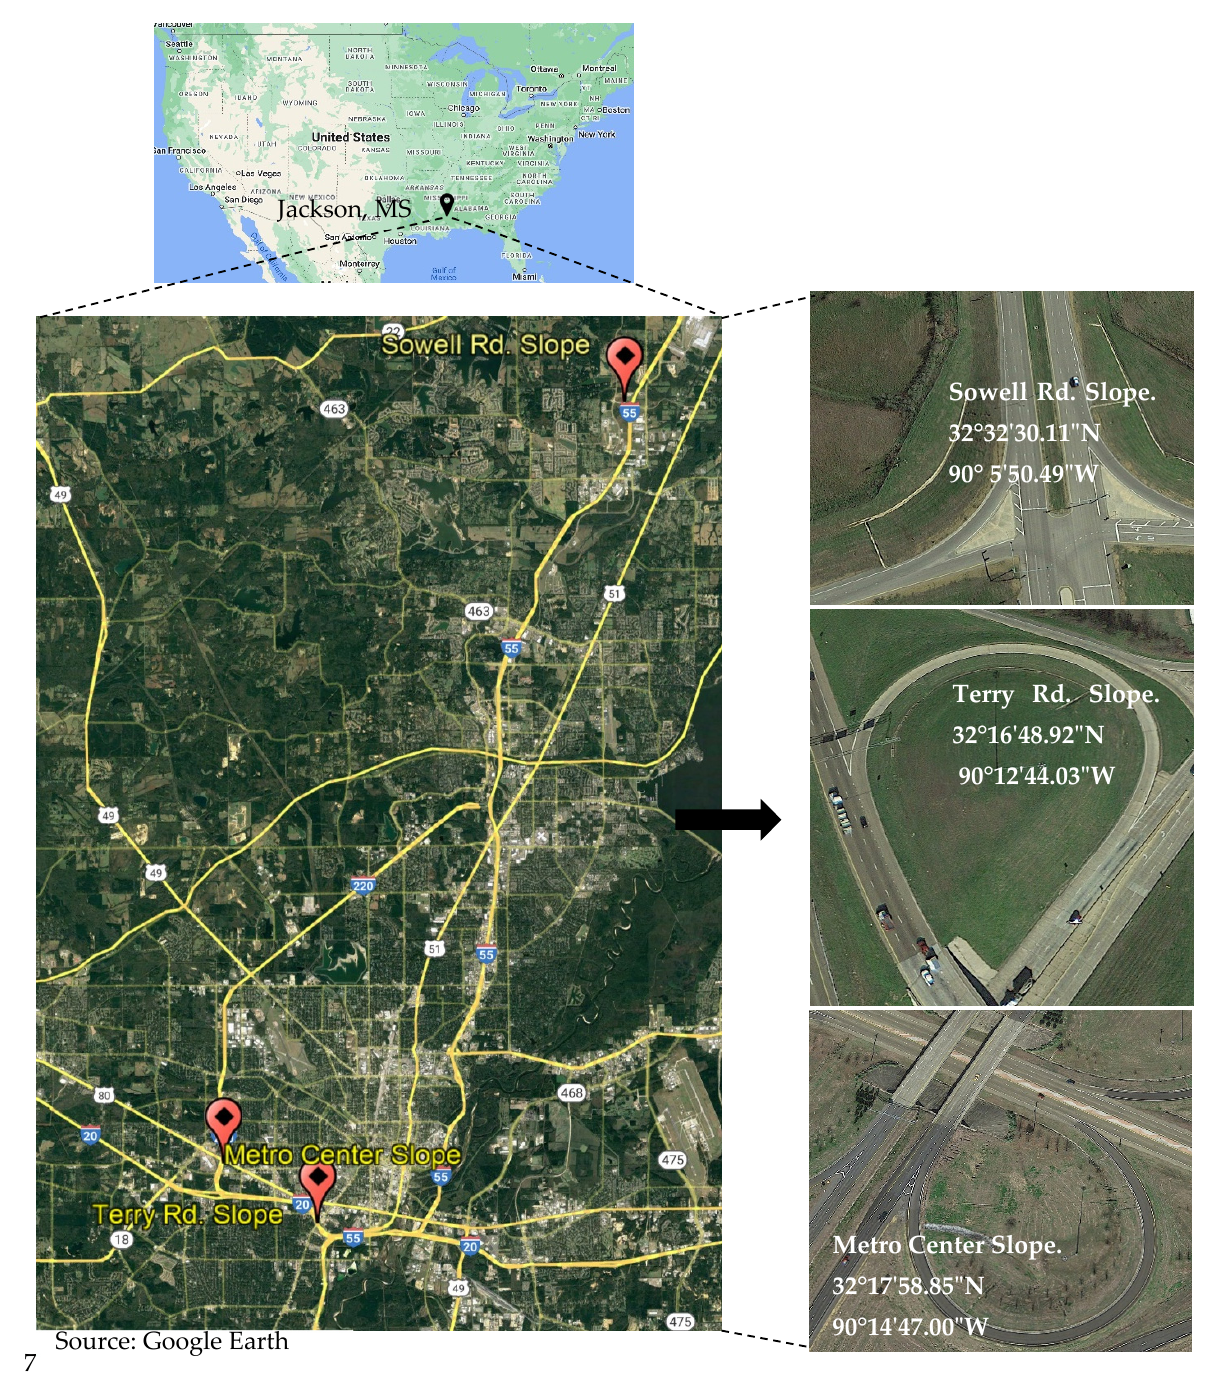
Figure 1. Highway embankment locations.